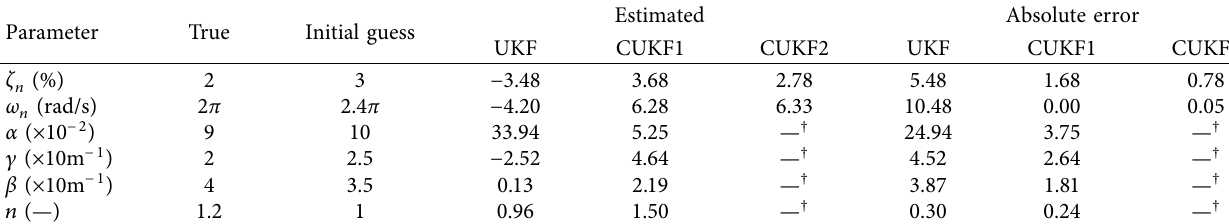
Figure 3: Results of parameter identification in Example 1. Table 2: Model parameters used in Example